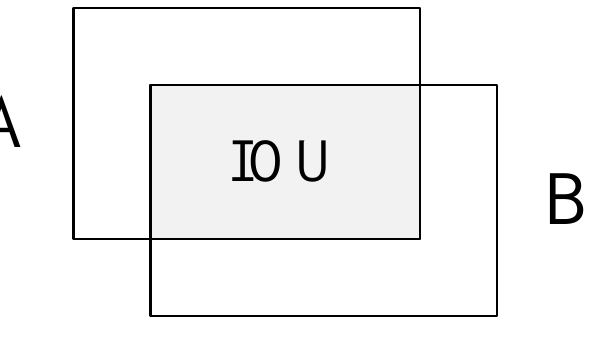
Figure 4. Schematic drawing of IoU calculation, where A and B are the ground-truth box and region proposal respectively.